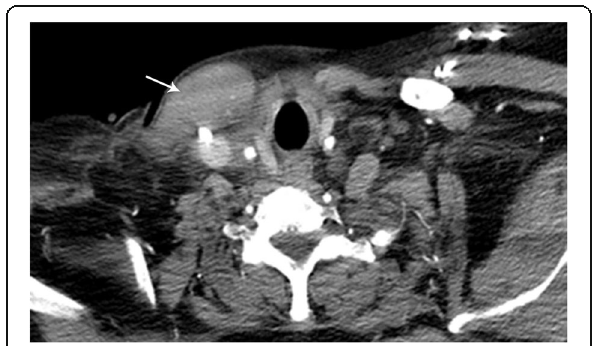
Fig. 25 Right sternocleidomastoid hematoma. Axial contrast CT images demonstrate an asymmetric enlargement of the right sternocleidomastoid muscle (arrow) in a trauma patient consistent with an intramuscular hematoma